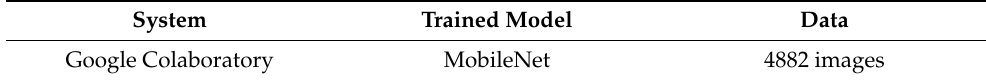
Table 3. Experimental environment.